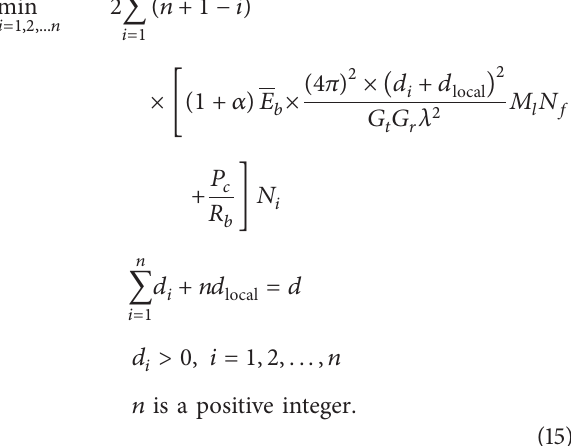
Figure 11: Total energy consumption per bit for each cluster, 2 bits transmission.